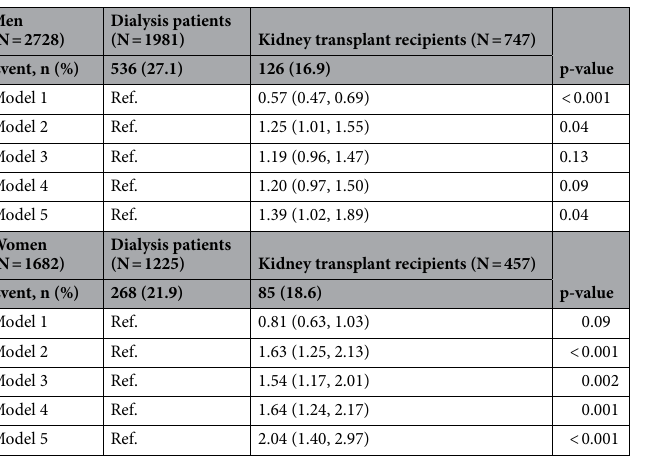
Table 3. Association of type of renal replacement therapy (kidney transplant vs dialysis) with 3-month mortality in men (upper panel) and women (lower panel) with COVID-19 (presented are hazard ratios with 95% confidence intervals). Model 1: crude. Model 2: Model 1 + age (continuous), clinical frailty score (continuous). Model 3: Model 2 + the reason for COVID-19 screening (symptoms-based screening/positive COVID-19 contact or routine screening). Model 4: Model 3 + smoking (never, current, former), obesity (yes/ no), hypertension (yes/no), diabetes (yes/no), heart failure (yes/no), chronic lung disease (yes/no), coronary artery disease (yes/no), and auto-immune disease (yes/no). Model 5: Model 4 + duration of kidney function replacement therapy (years) and estimated glomerular filtration rate (continuous). (p-for interaction between sex and type of kidney function replacement therapy = 0.02 in fully adjusted model for 3 month